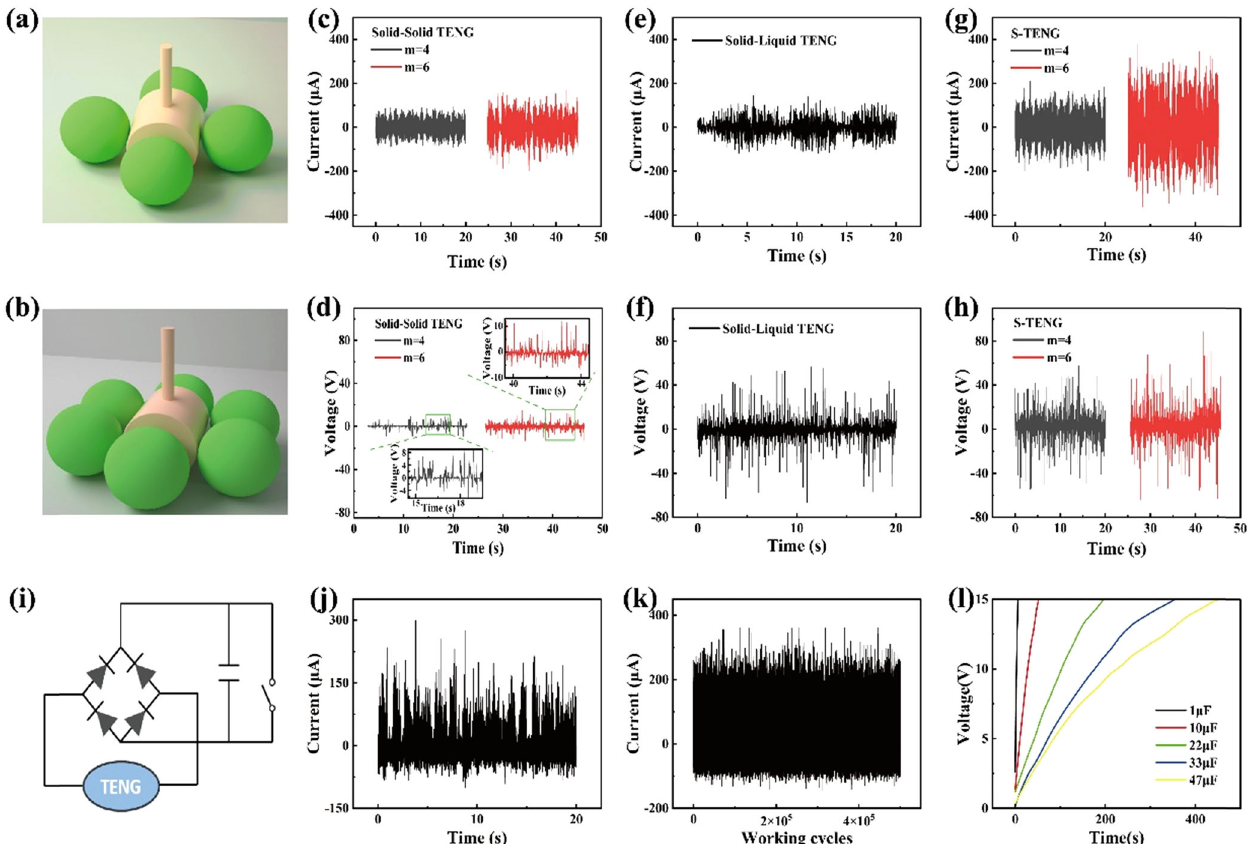
Fig. 3 The electrical characterizations of S-TENG. a and b Schematic diagram of sponge balls with different numbers. Short-circuit current ( c ) and open-circuit voltage ( d ) of the solid-solid TENG with different numbers of sponge balls. Short-circuit current ( e ) and open-circuit voltage ( f ) of the solid-liquid TENG. Short-circuit current ( g ) and open-circuit voltage ( h ) of the S-TENG with different numbers of sponge balls. i Schematic diagram of recti fi er circuit of TENG. j The recti fi ed current of the S-TENG. k Stability test of the S-TENG. l The charging curves of different capacitors charged by the S-TENG in the wave tank